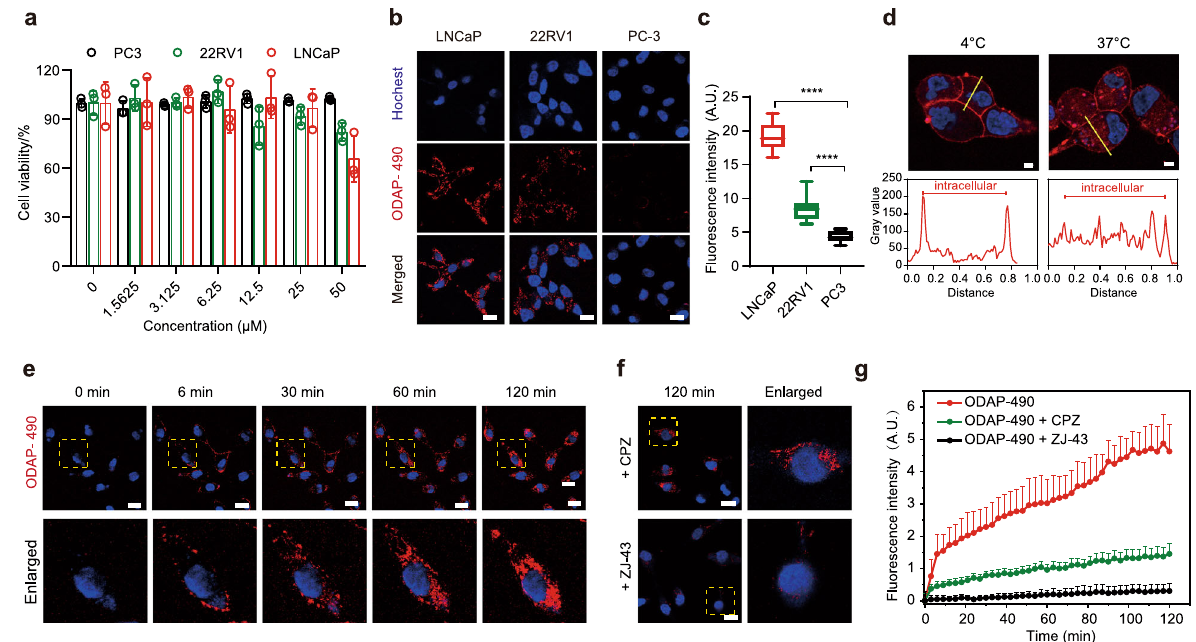
Fig. 3 Wash-free imaging of PSMA and real-time imaging of PSMA-mediated endocytosis. a Cytotoxicity of ODAP-490 determined by the MTT viability assay. Data are presented as mean ± s.d. ( n = 3 independent experiments). b Wash-free imaging of LNCaP (PSMA +++ ), 22RV1 (PSMA + ), and PC3 (PSMA − ) cells. 10 μ M ODAP-490 was applied at 37 °C for 2 h. Cell nuclei were counter-stained with hochest 33342. (red, ODAP-490; blue, hochest 33342). Scale bar: 20 μ m. c Quanti fi cation of the fl uorescence intensity of samples in panel b . Upper and lower bounds of boxes represent 25th and